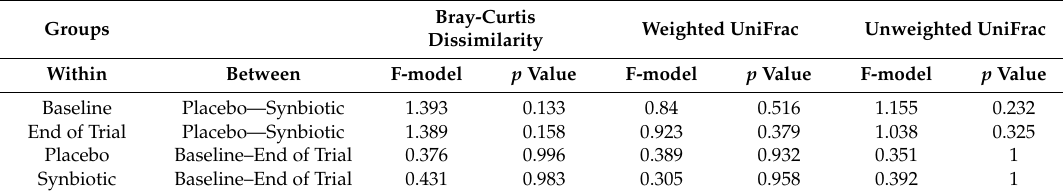
Table 3. Measuring statistical significance of beta diversity di ff erences between groups using Permutational Multivariate Analysis of Variance (PerMANOVA) on models with beta diversity as the response variable, and treatment group and time point as predictive variables. Three beta diversity metrics were used (Bray–Curtis, weighted UniFrac, and unweighted